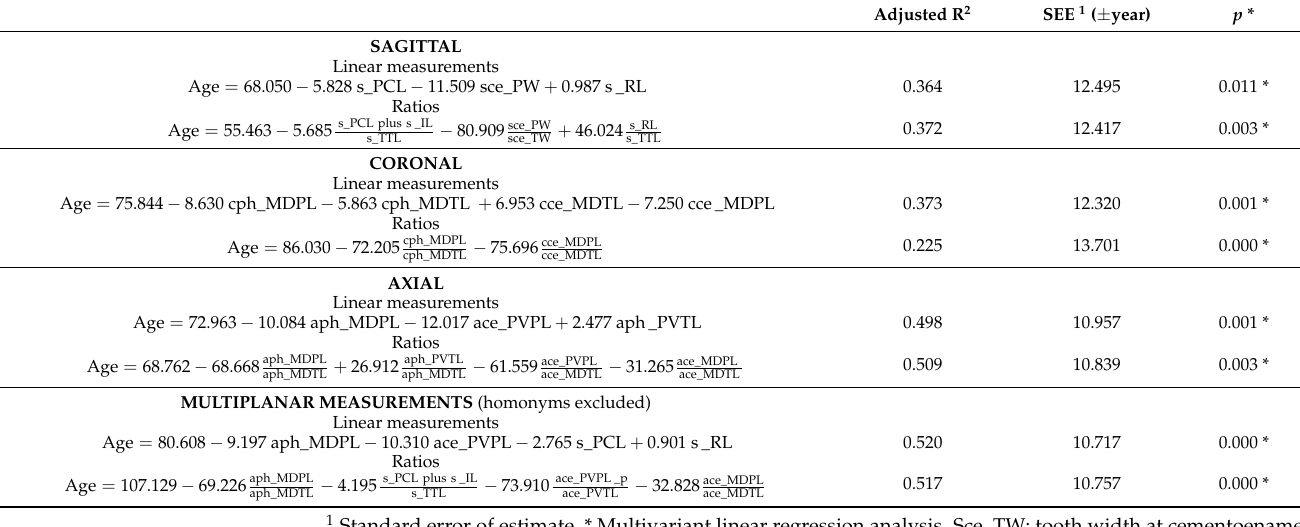
Table 4. Multiple linear regression models for age estimation based on upper central